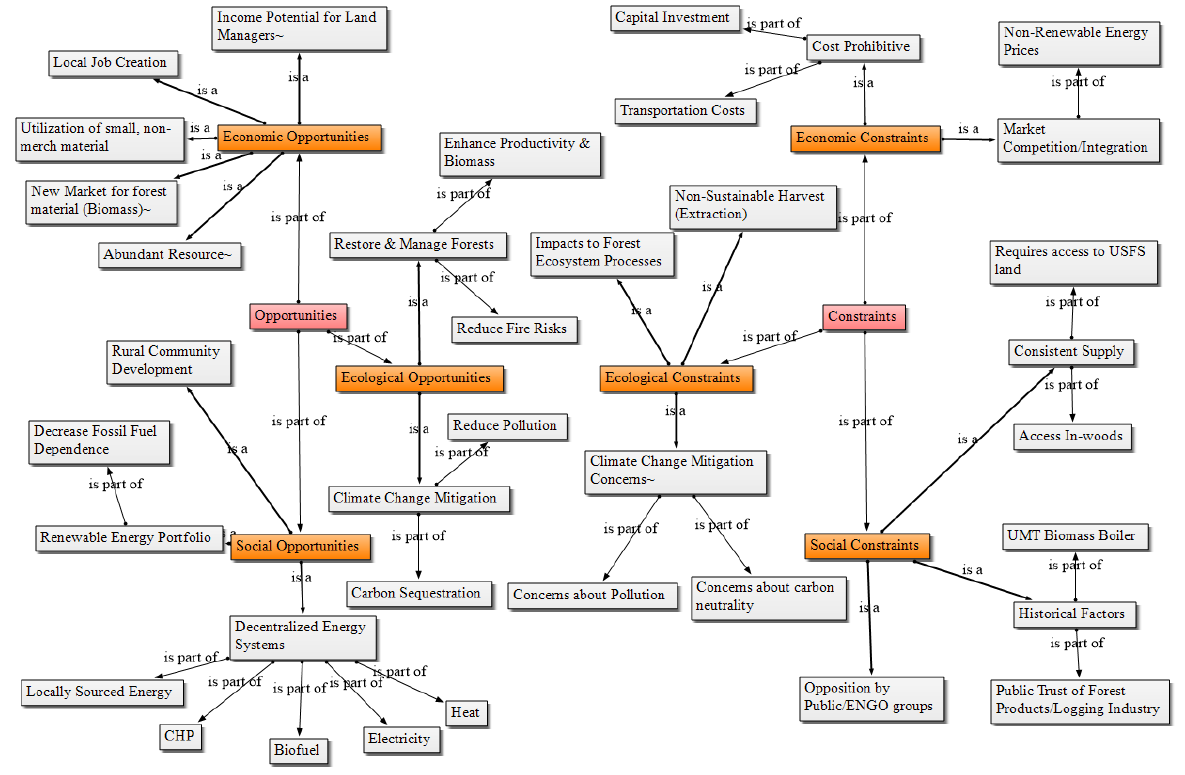
Fig. A2.1. Network analysis of the opportunities and constraints of wood-based bioenergy (WBB) in western Montana . The “opportunities” and “constraints” themes (Pink boxes) are organized around “social”, “economic”, and “ecological” concepts (Orange boxes). The links between the opportunities and constraints themes and the social, economic, and ecological concepts are denoted with a “ is part of” relationship. Several codes and sub-codes (Gray boxes) are attached to each concept. Root codes associated with each concept are linked with a “ is a” relationship. Links are also made between root codes and sub-codes with a “is part of” relationship. This iterative and inductive approach resulted in 20 codes associated with the “opportunities” theme, 10 of which were root codes and 10 of which were defined as sub-codes. Alternatively, 17 codes were identified under the “constraints” theme, 8 of which were considered root codes, and 9 were defined as